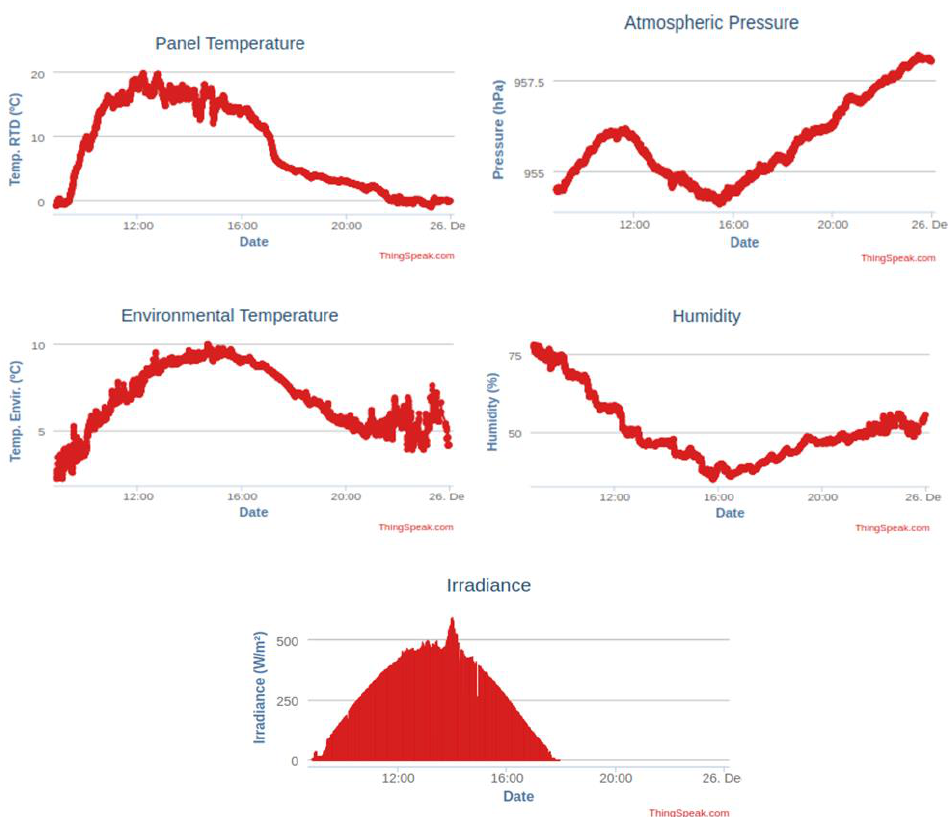
Figure 9. Interface of Thingspeak to visualize stored variables: panel and environment temperature, humidity, irradiance, wind speed and wind direction.